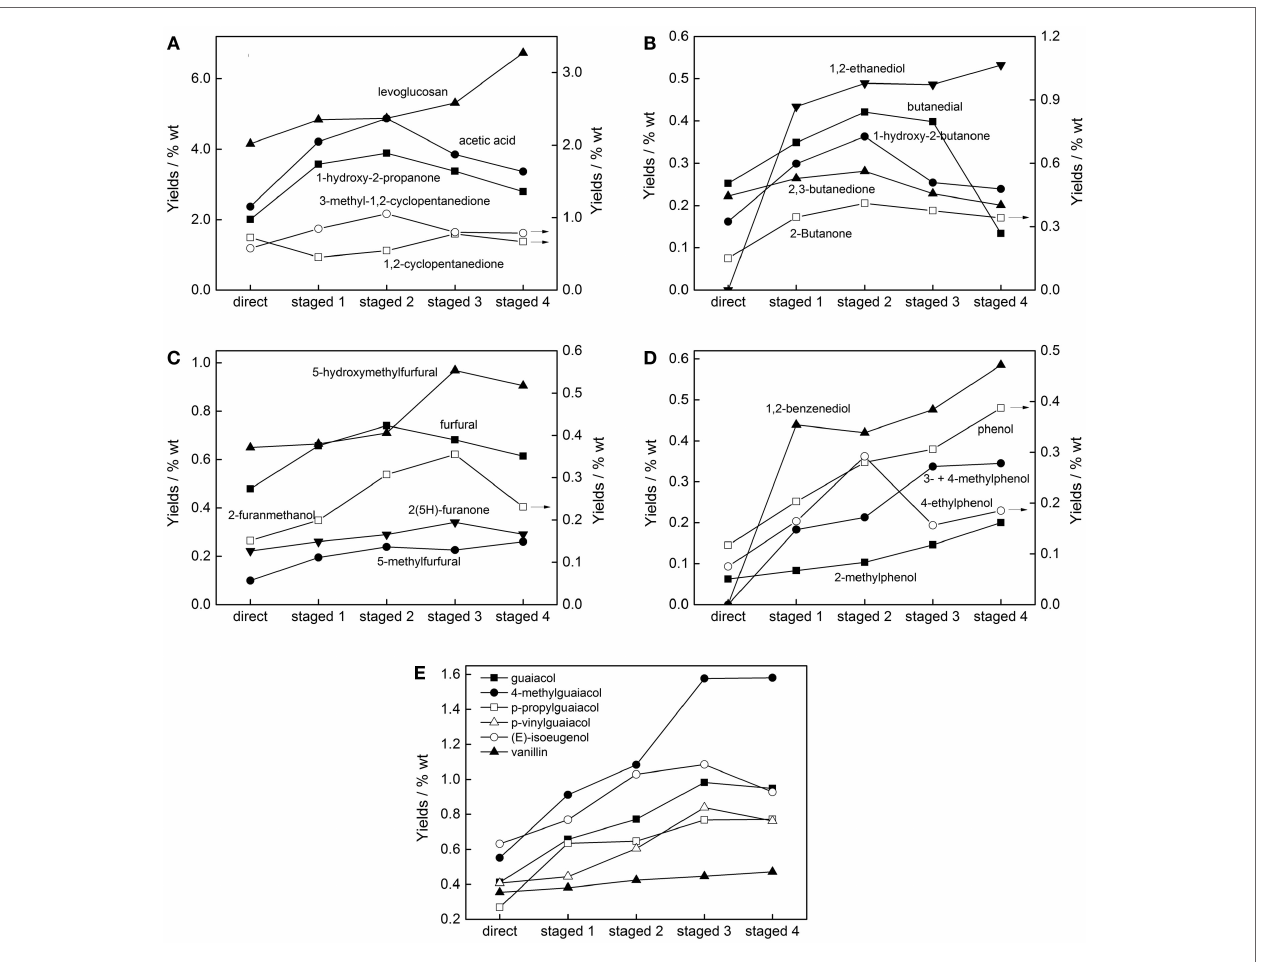
FigUre 7 | influence of pretreatment temperature on the yields of (a) major carbohydrates, (B) minor carbohydrates, (c) furans, (D) h-phenols, and (e) g-phenols of pine pyrolysis bio-oils (staged 1, 2, 3,